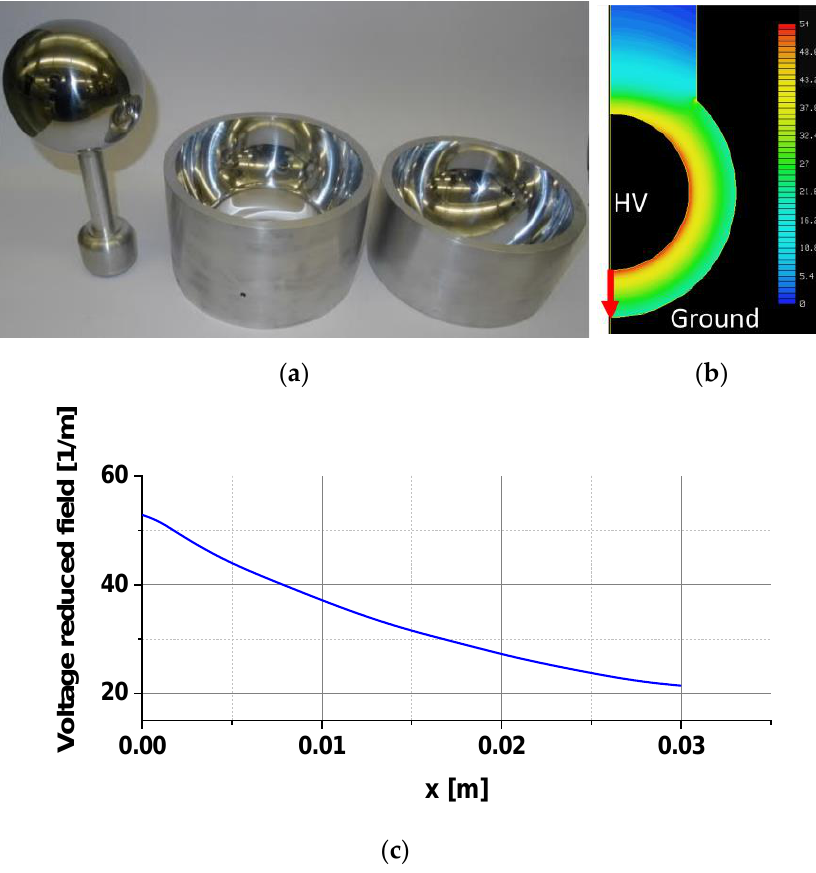
Figure 3. ( a ) Photograph of the electrodes of set-up 2. ( b ) Numerical simulation of the electric field distribution in set-up 2, the concentric electrode configuration with a 30 mm gap. ( c ) Electric field strength decay along the axis of symmetry indicated by the red arrow in ( b ).